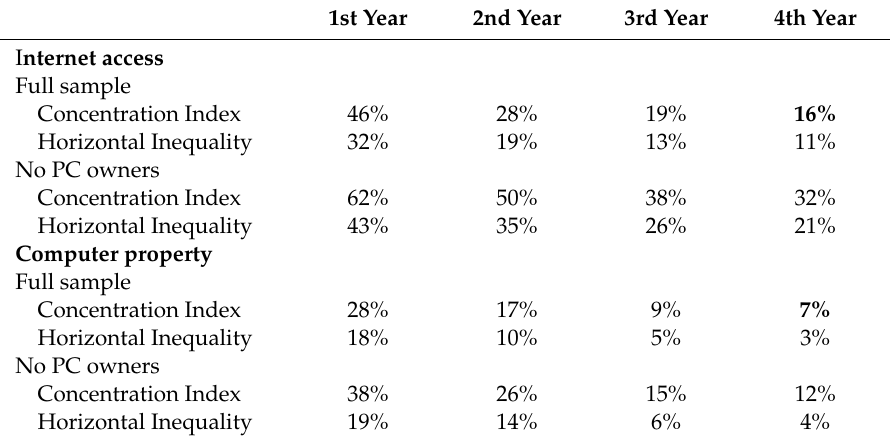
Table 9. Evolution of the Concentration Index (CI) and Horizontal Inequality